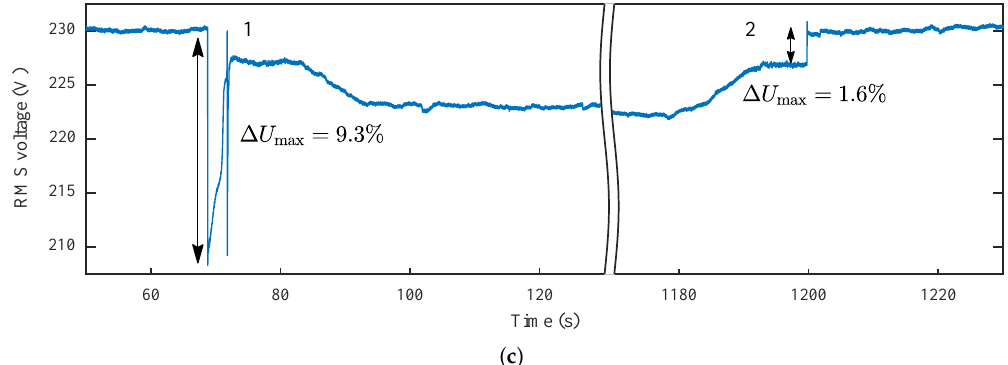
Figure 4. Examples of RVCs recorded at Site 1 ( a ); Site 2 ( b ); and Site 3 ( c ).